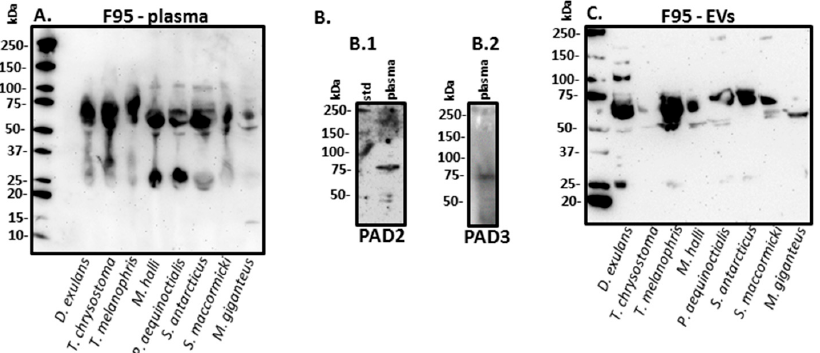
Figure 3. Deiminated proteins in seabird plasma and plasma-derived EVs. ( A ) Deimination positive protein bands, as assessed by the pan-deimination F95 antibody, were observed in plasma of all eight bird species tested in this study, in the size range of 25–150 kDa. ( B ) Peptidylarginine deiminase (PAD) homologues via cross reaction with anti-human PAD2 antibody ( B.1 ) and anti-human PAD3 antibody ( B.2 ) were observed in seabird plasma at an expected size of approximately 75 kDa. The protein standard (std) is indicated in kilo Daltons (kDa) on the left hand side of each blot. ( C ) Plasma-derived EVs were positive for deiminated proteins, as assessed by the pan-deimination F95 antibody, in plasma-EVs isolated from all eight bird species tested in this study. This confirms EV-mediated export of deiminated